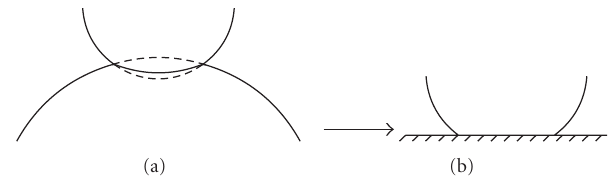
Figure 1: Reduction of the elastic contact between two balls to that of one ball and a rigid flat